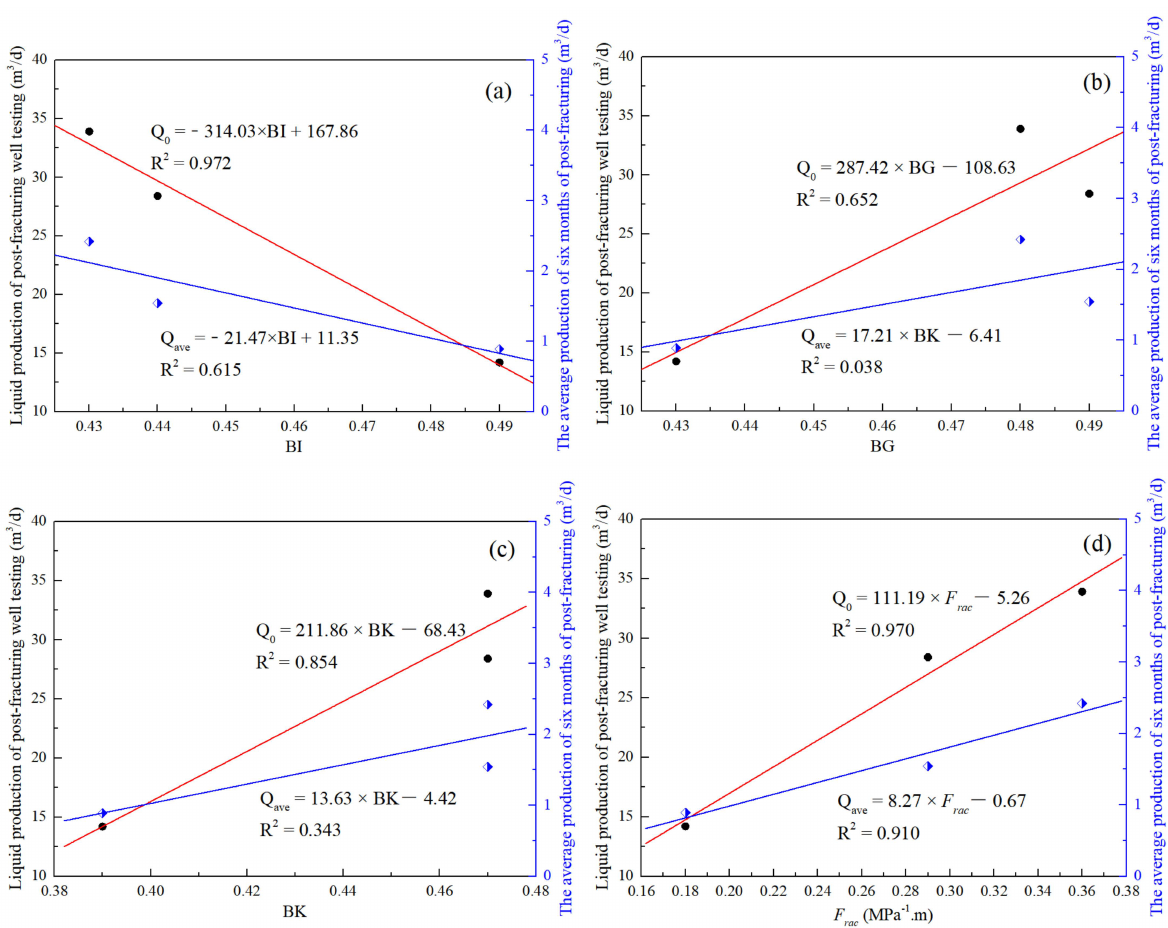
Figure 10. The correlations between the corresponding index and history of production for ( a ) BI model, ( b ) BG model, ( c ) BK model, and ( d ) F rac